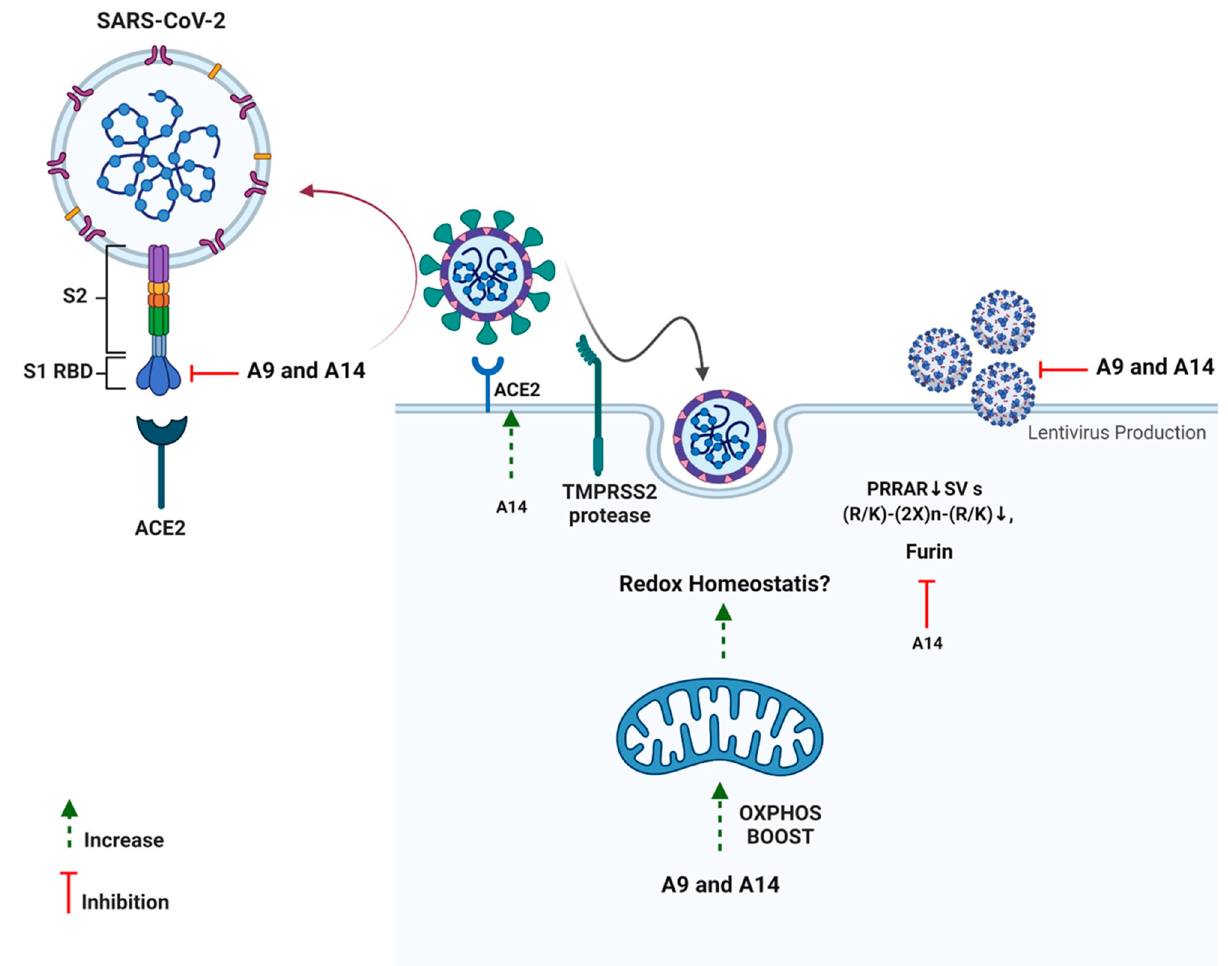
Figure 9. Schematic presentation of impact of peptides A9 and A14 against